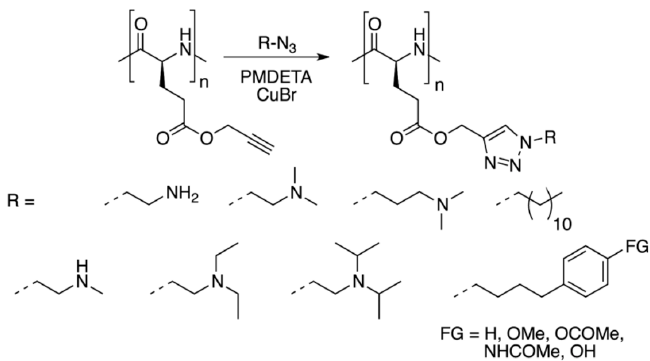
Figure 18. Poly( γ -propargyl- L -glutamate) clicked to various amines to obtain polycationic [87] or hydrophobic polymers [88].